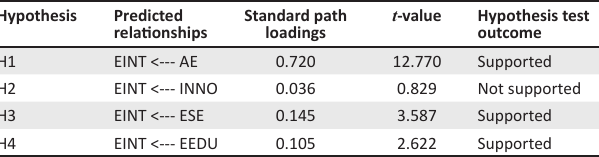
TABLE 7: Results of path analysis and hypotheses